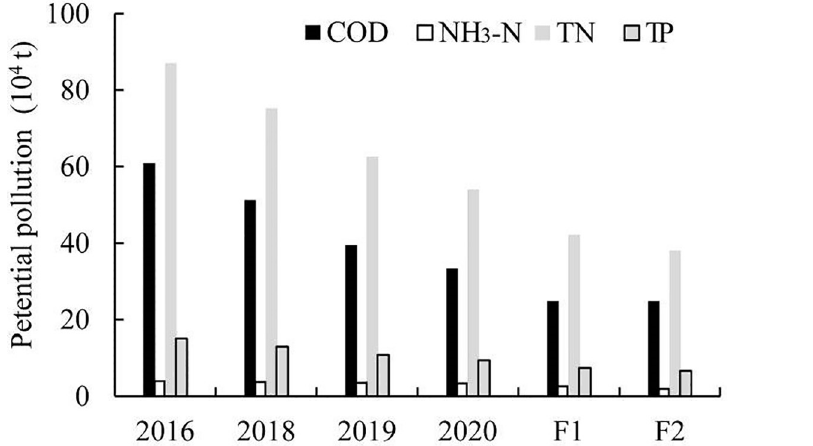
Fig 5. Potential pollution under different